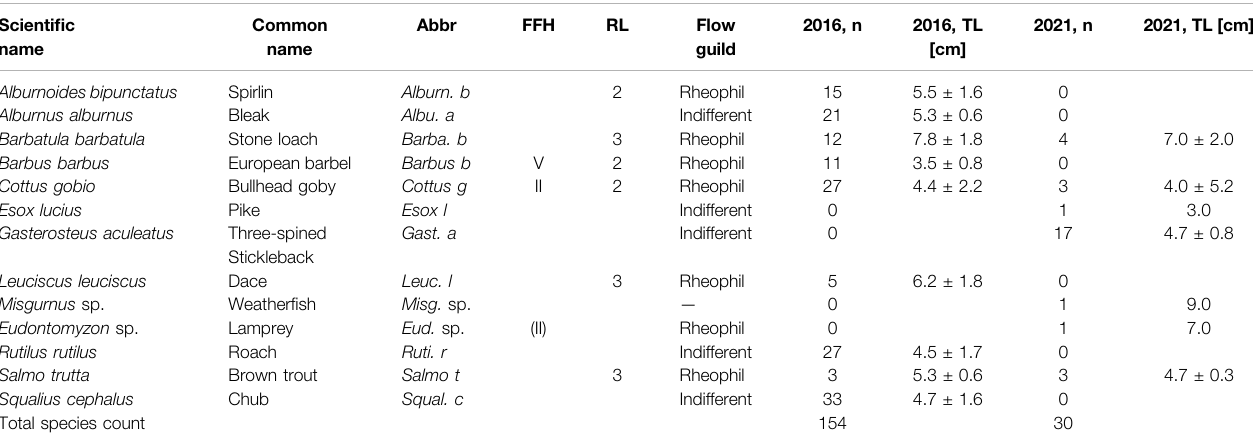
TABLE 3 | List of stranded species during the dewatering in 2016 and